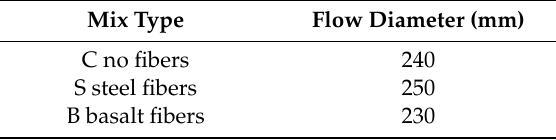
Table 3. Concrete mix flow diameter (mm).